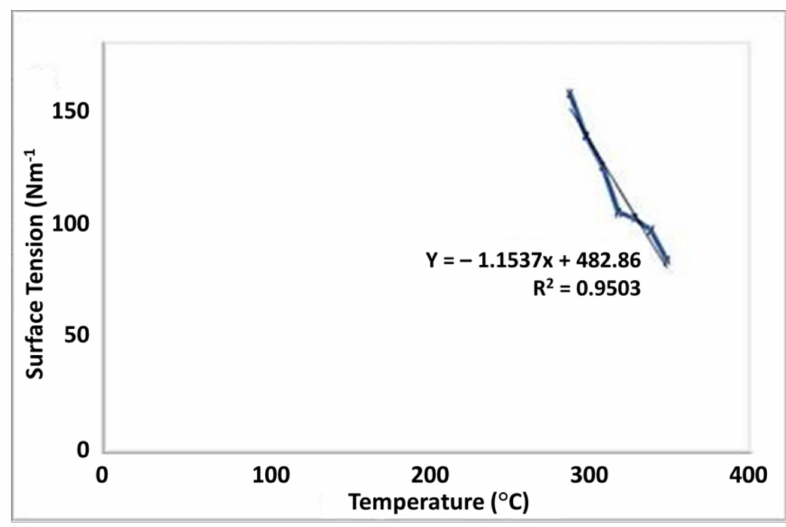
Figure 3. Graphical representation of temperature dependant surface tension.